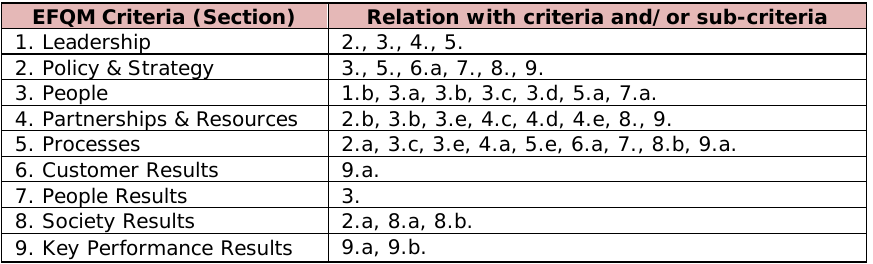
Table 1. “Cause and effect